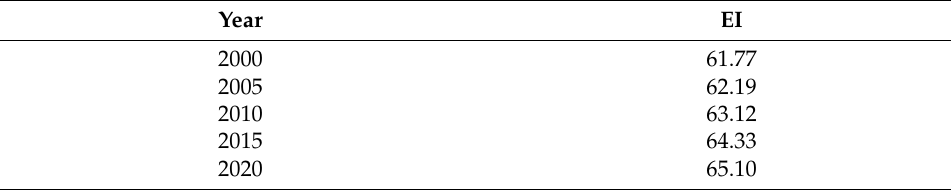
Table 10. Value of EI in Rangtang County.